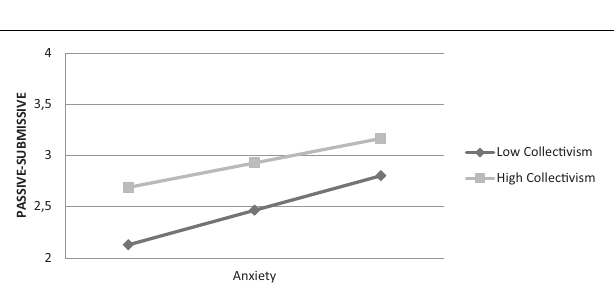
FIGURE 2 | Effect of anxiety on passive-submissive coping style is moderated by